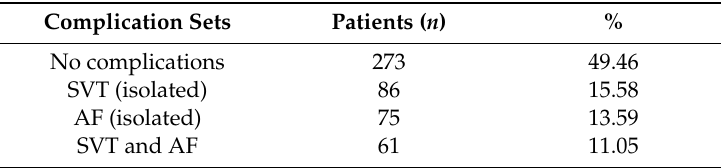
Table 1. Results of the dichotomous analysis of cardiac